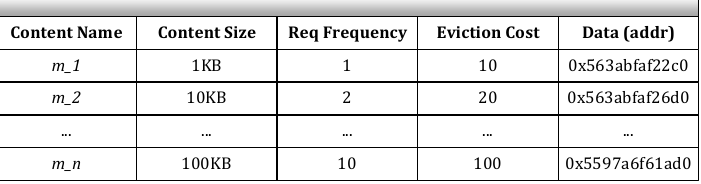
Figure 9. Example of content information table maintained by each